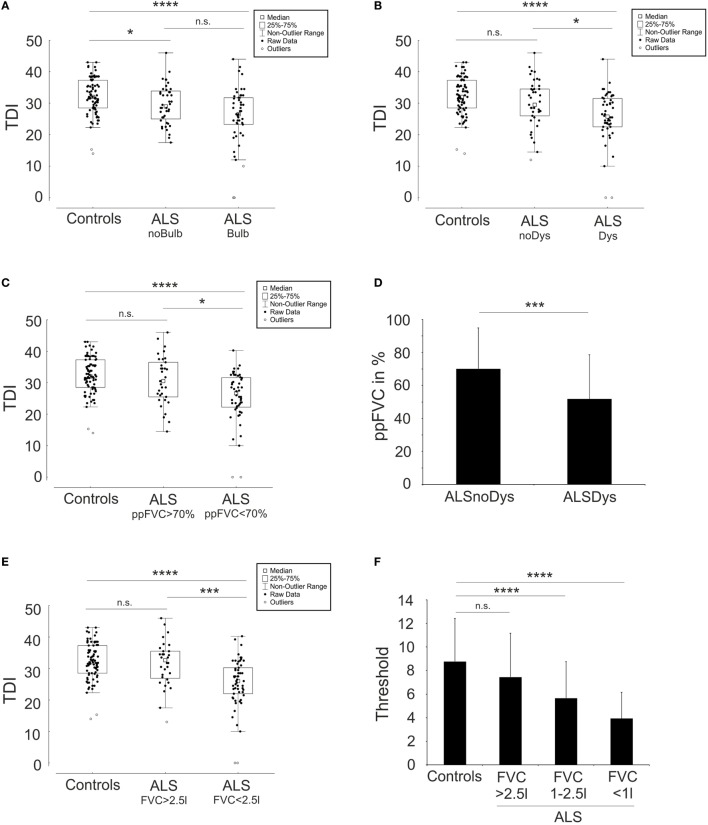
Olfactory dysfunction is a consequence of respiratory dysfunction. Depicted are box plots with single values (dots) concerning the comparison of the composite of the three subtests (TDI) scores of the “Sniffin Sticks” test results between amyotrophic lateral sclerosis (ALS) patients with (Bulb) and without (noBulb) bulbar symptoms (A), the comparison between ALS patients with (Dys) and without (noDys) dyspnea (B), the comparison between ALS patients with >70% and <70% forced vital capacity of predicted (ppFVC) (C), and the comparison between ALS patients with >2.5l and <2.5l forced vital capacity (FVC) (E). (D) shows the difference of ppFVC between ALS patients with (ALSDys) and without (ALSnoDys) dyspnea. In (F), the decline of the subtest threshold “T” of the “Sniffin Sticks” test is depicted in comparison to FVC. ****p < 0.0001, ***p < 0.001, **p < 0.01, *p < 0.05, not significant (n.s.).